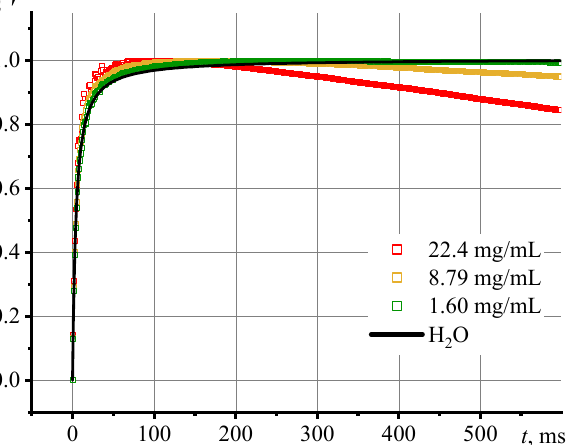
Figure 7. Transient thermal lens signal, Equation (9), for various concentrations of a dispersion of silicon oxide nanoparticles (HS series, d av = 12 nm) for the first 600 ms.